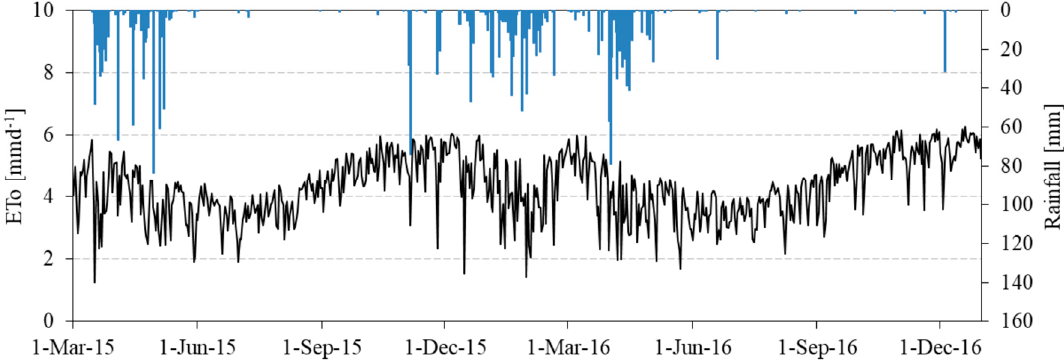
Figure 2. Daily rainfall and ET 0 values used during the simulation period.